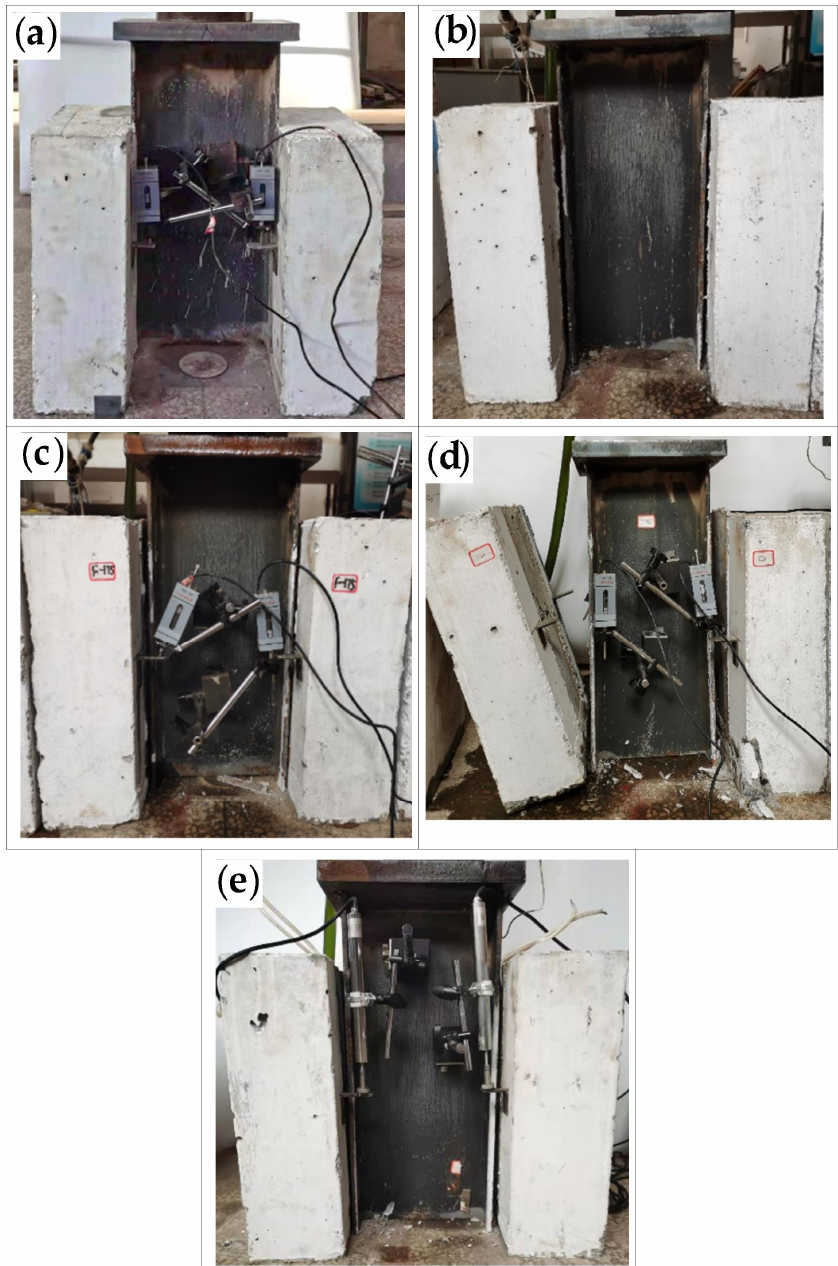
Figure 8. Shear fracture of studs in the concrete slab on both sides of the specimen: ( a ) specimen F-2; ( b ) specimen F-3; ( c ) specimen F-6; ( d ) specimen F-7; ( e ) specimen F-8.